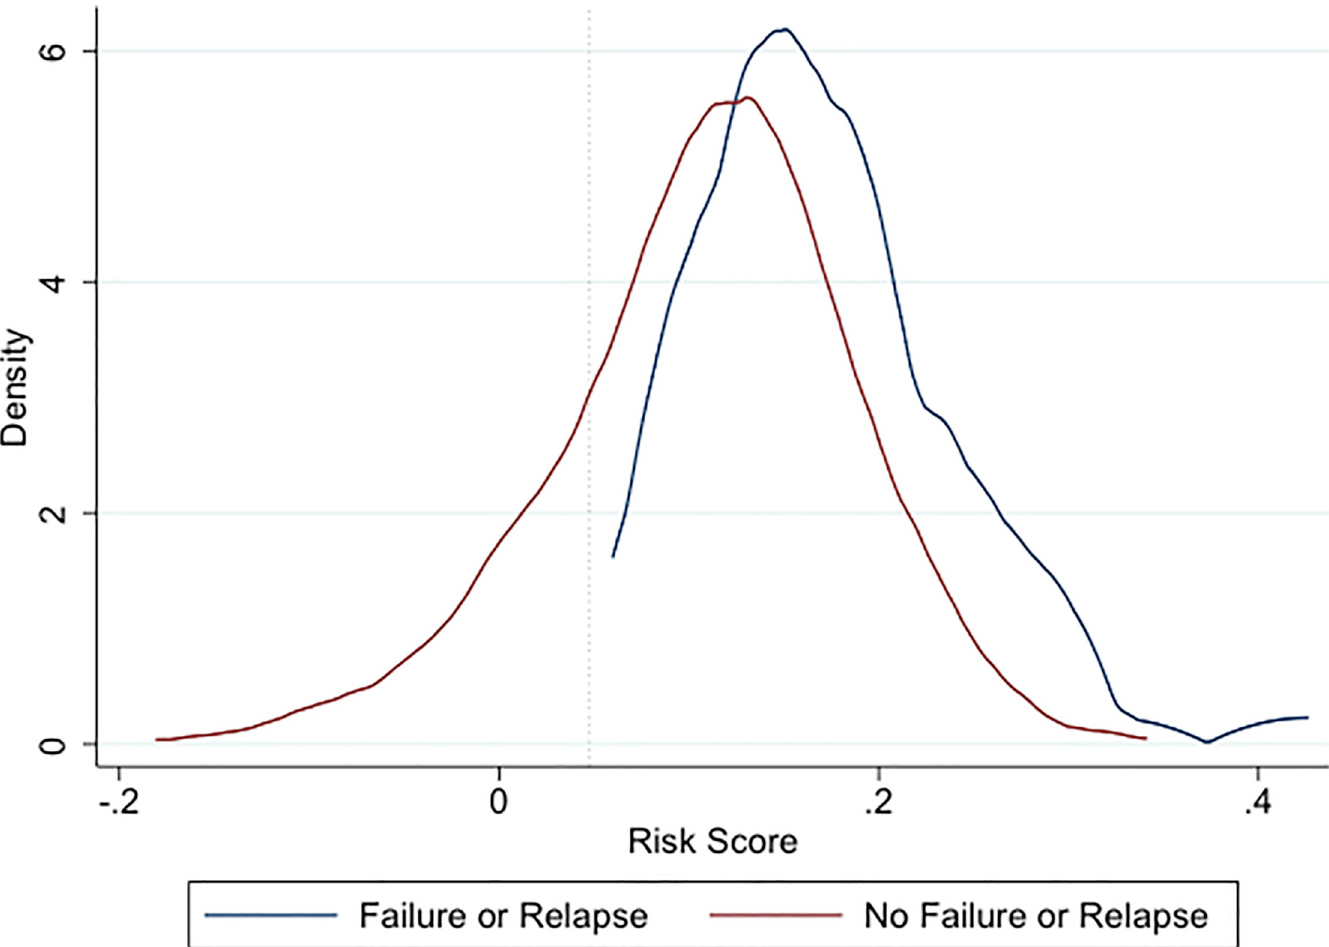
Fig 2. Risk prediction score